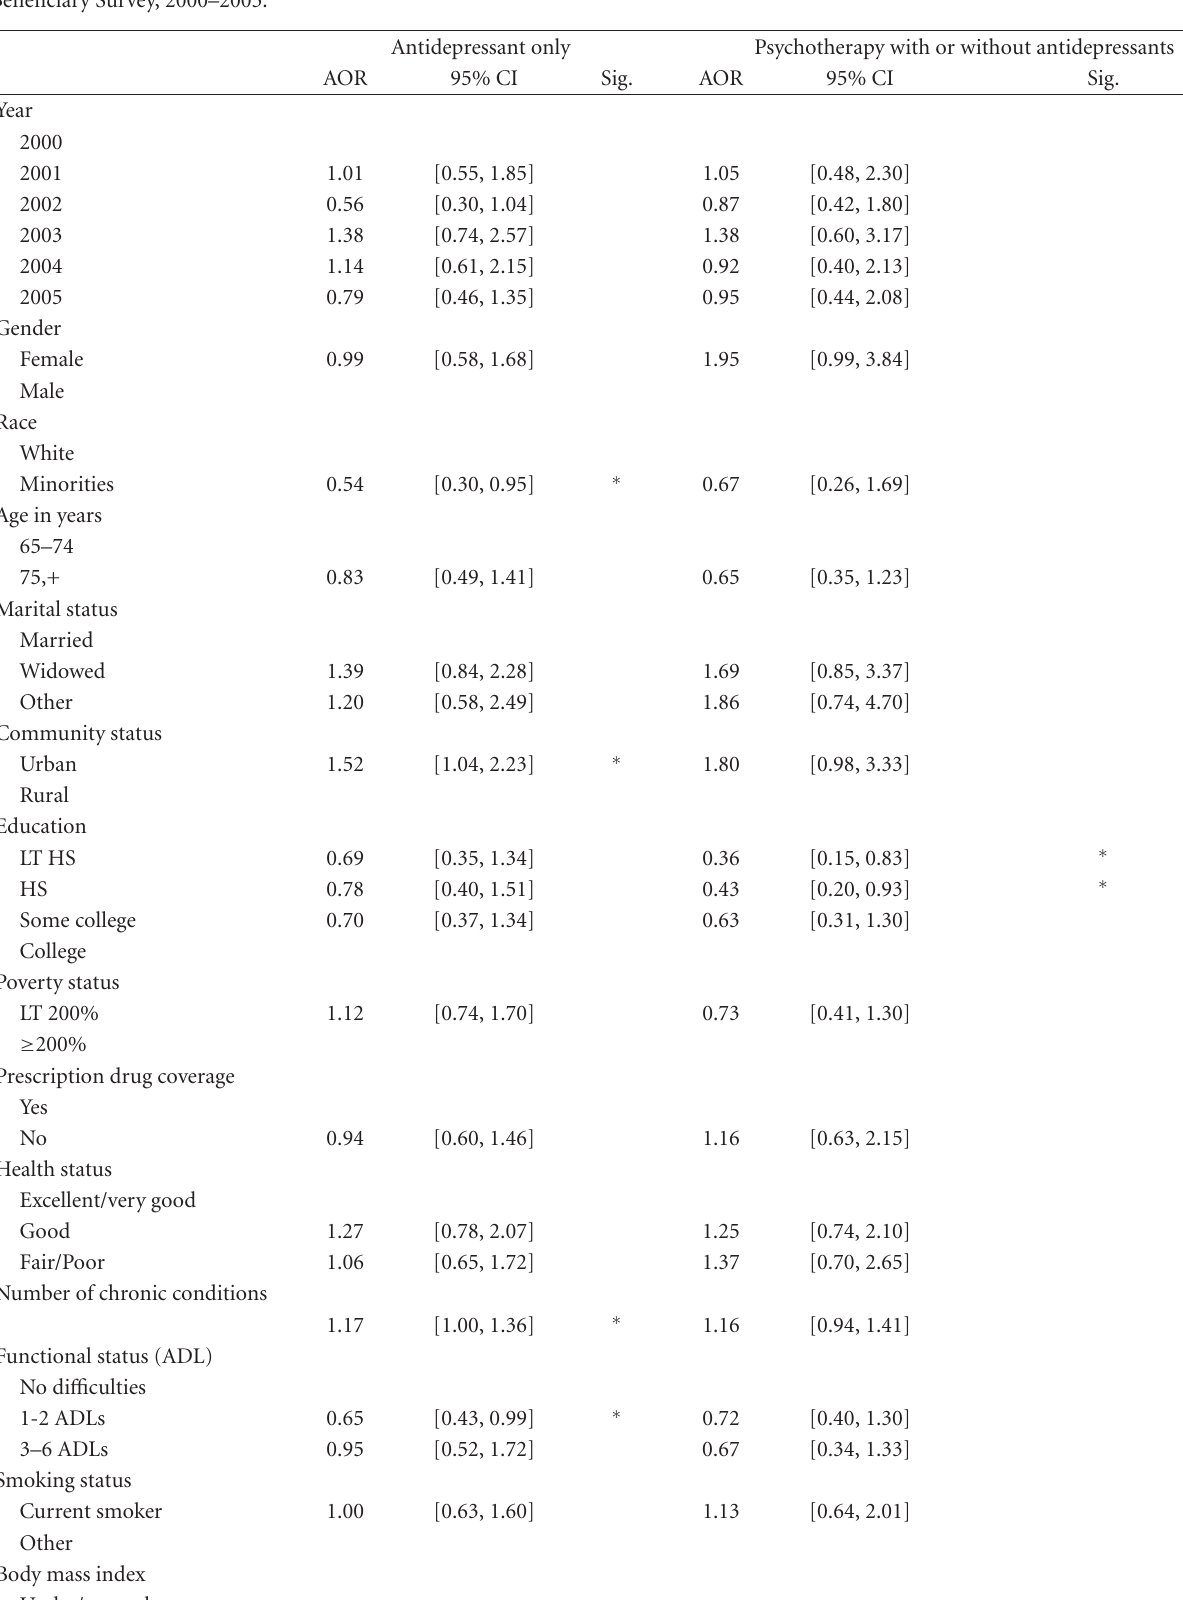
Table 3: Adjusted odds ratios and 95% confidence intervals from multinomial logistic regression on depression treatment. Medicare Current Beneficiary Survey,